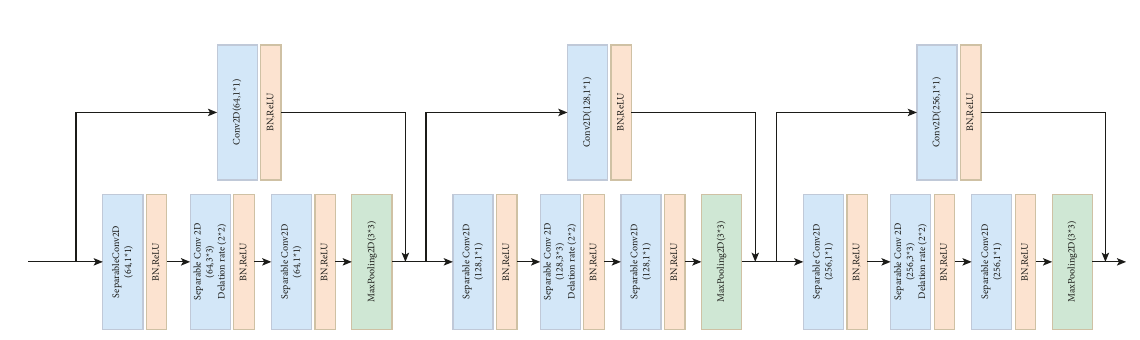
Figure 3: Block diagram of the